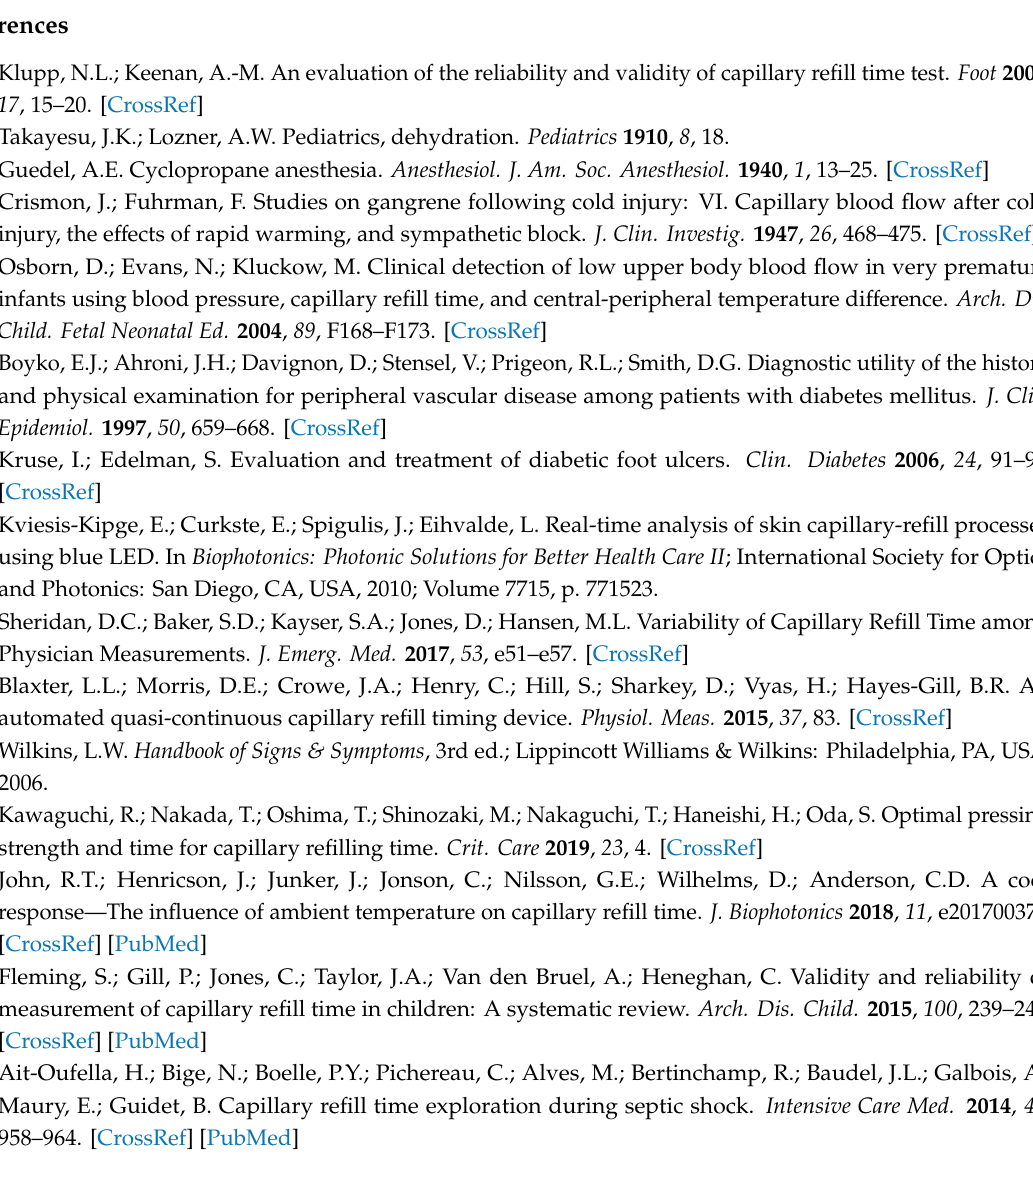
Figure S1: Temperature performance of FBG 1&2; Figures S2 to S11: 10 groups of experiments data